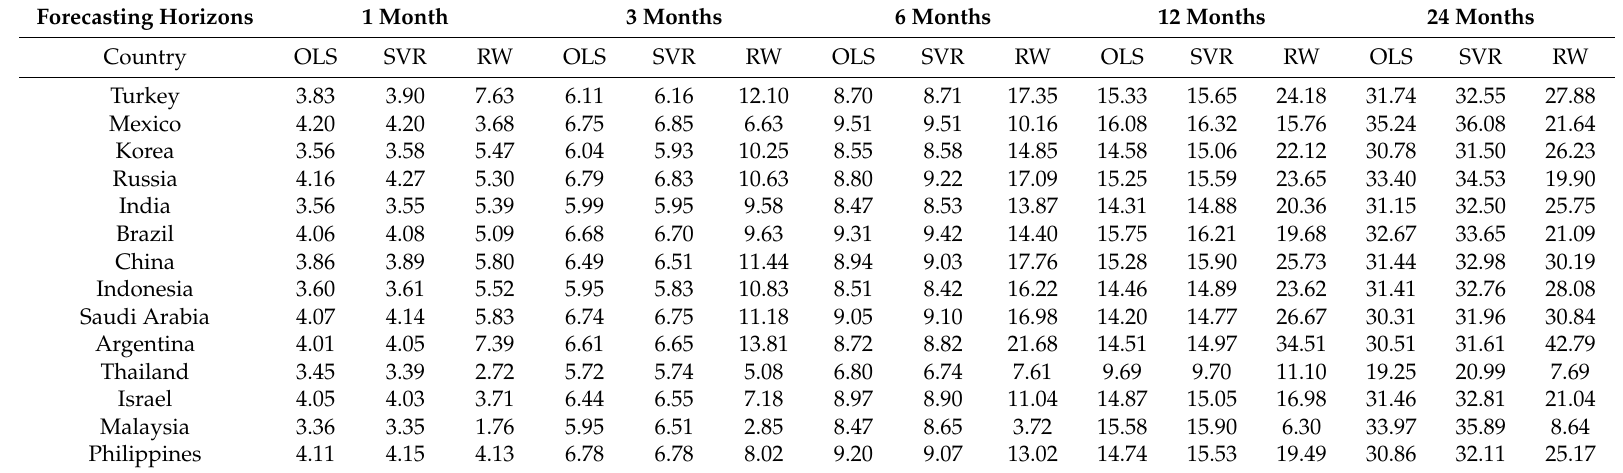
Table 5. Gold prices out-of-sample forecasting